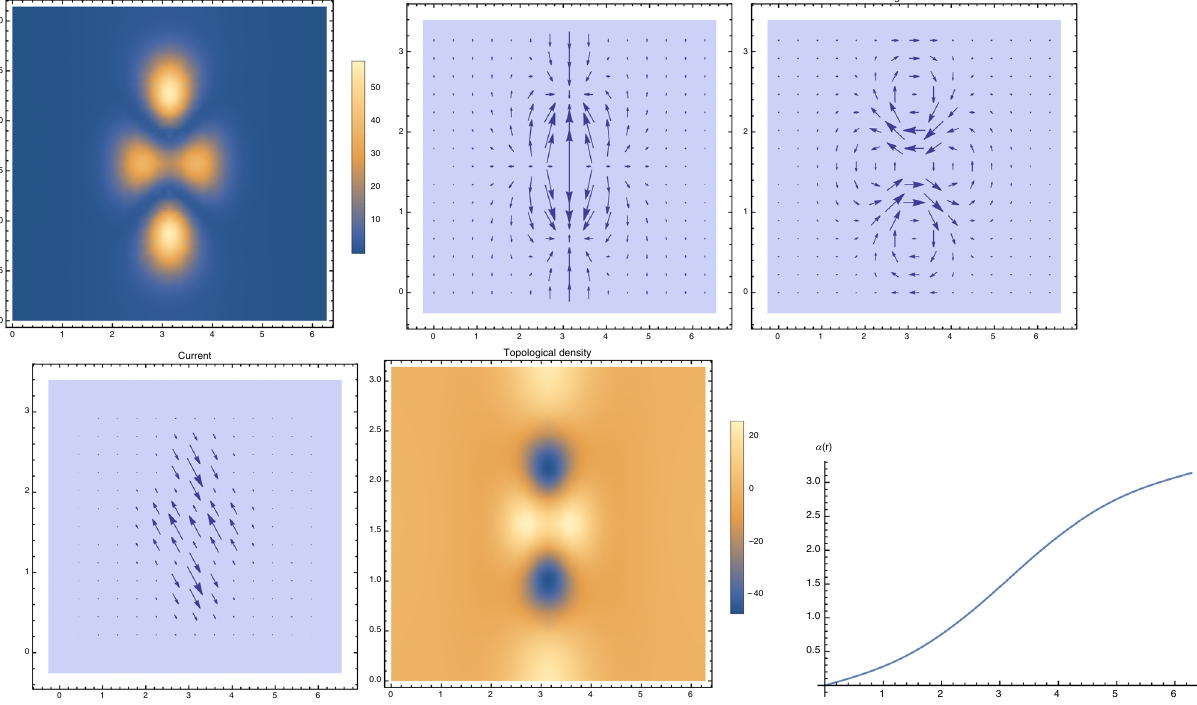
Fig. 4 Fromlefttoright:Energydensity E ,electricfield,magneticfield,current,topologicaldensity ρ B andradialprofile α( r ) ,uptothecontribution = L 12 for the configuration with B